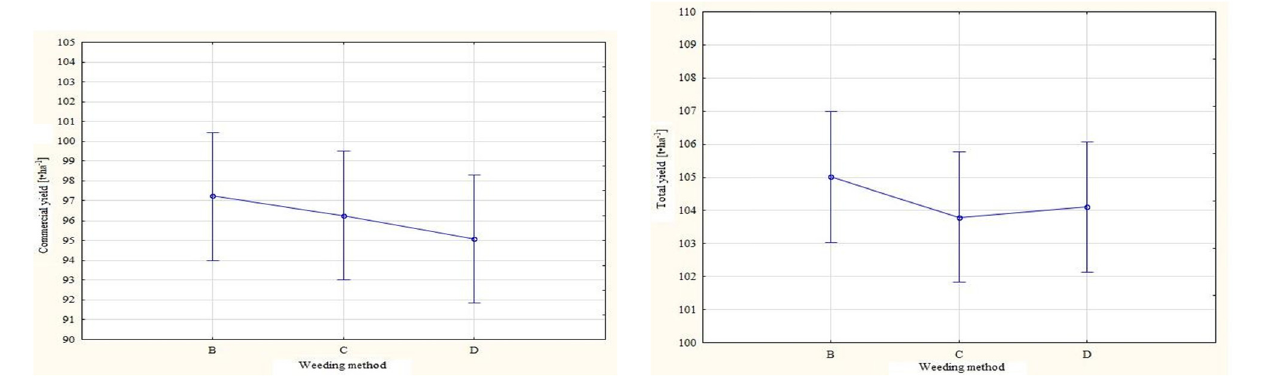
Figure 7: The expected marginal averages for 0.95 con fi dence intervals for commercial yield according to the various methods of weeding carrots in 2016 ( source: own work ) .